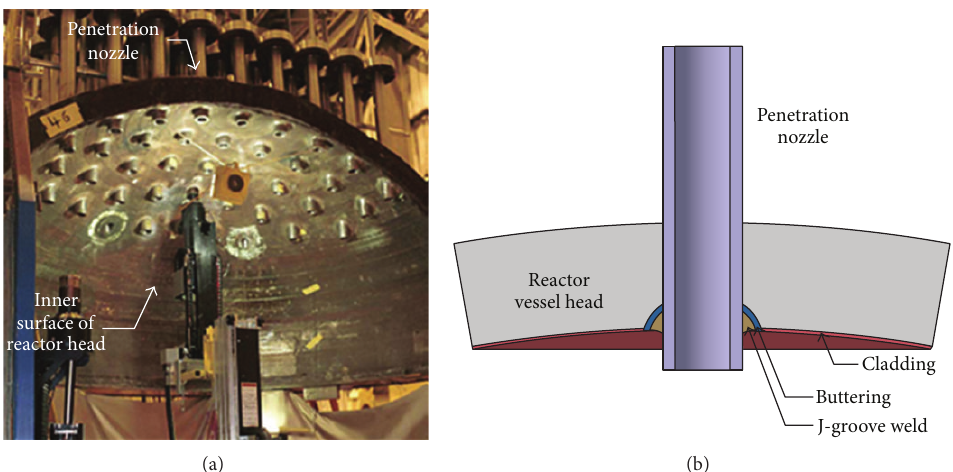
Figure 1: (a) Real photo of control rod drive mechanism (CRDM) assembly [10] and (b) schematic diagram of CRDM assembly.